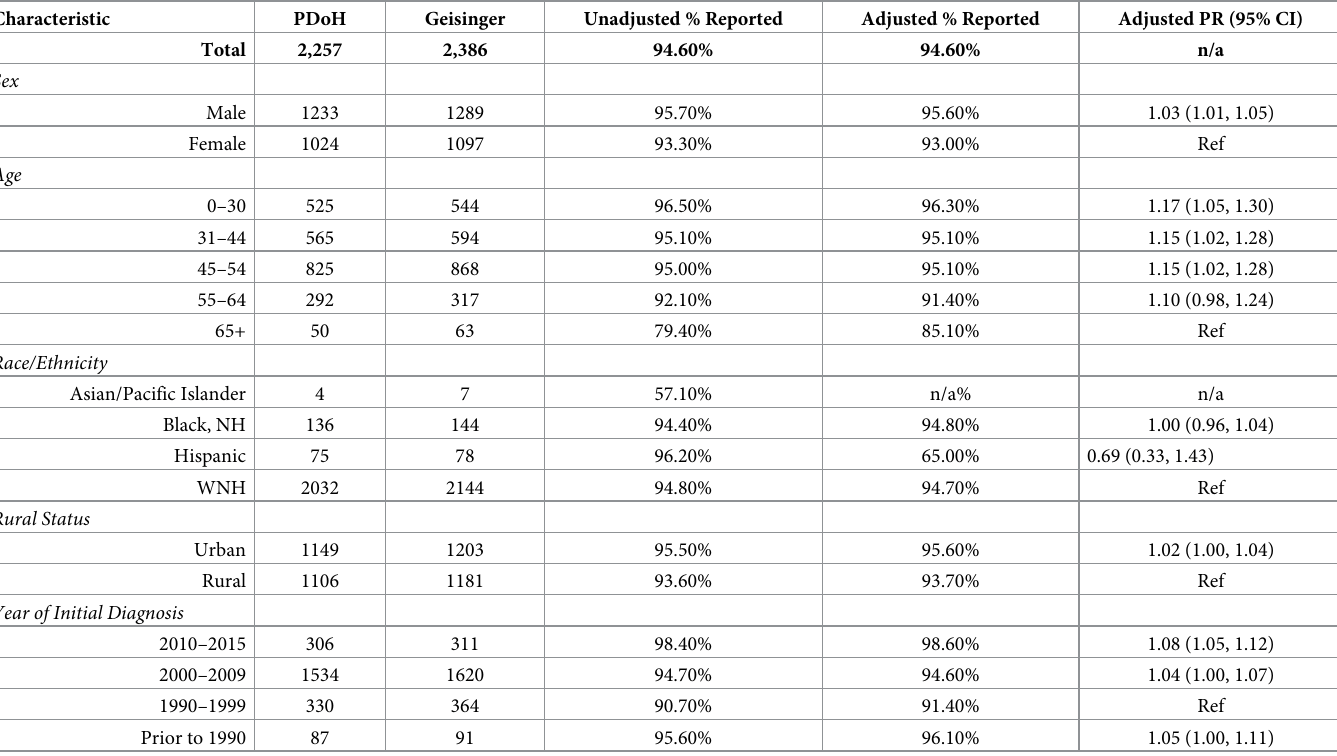
Table 2. Percentage of viral hepatitis C infections reported to the pennsylvania department of health, 2001–2015.